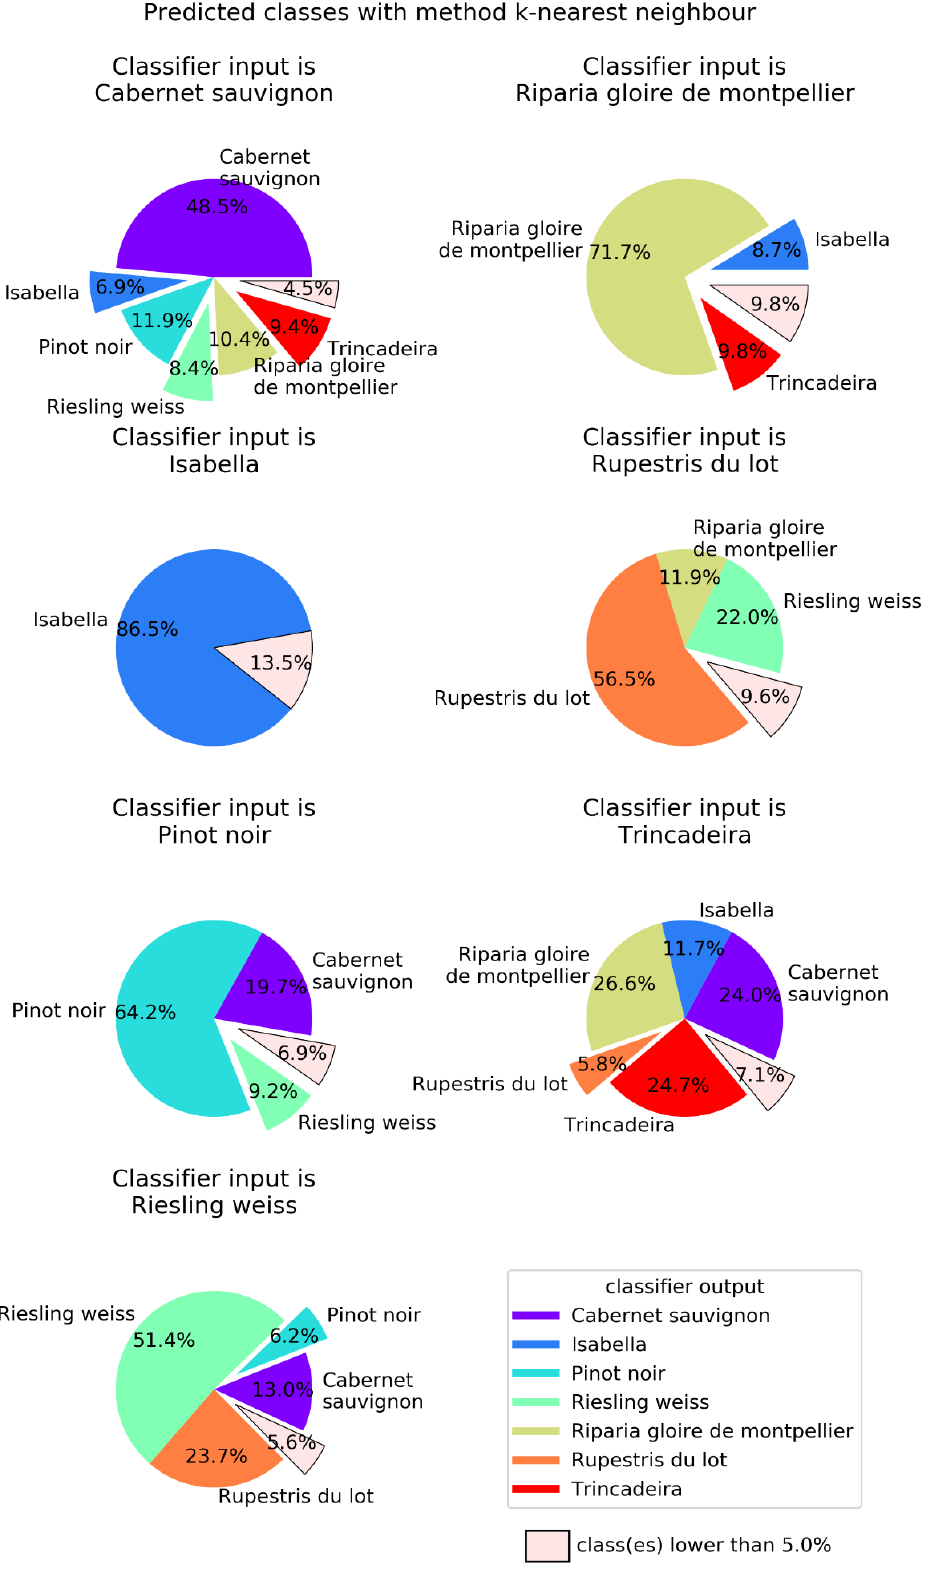
Figure 4. K-nearest neighbors (KNN) output for each of the possible seven input Vitis genotypes. KNN used k = 5 as the number of neighbors with which to perform the classification. Global success rate is 58.5%.